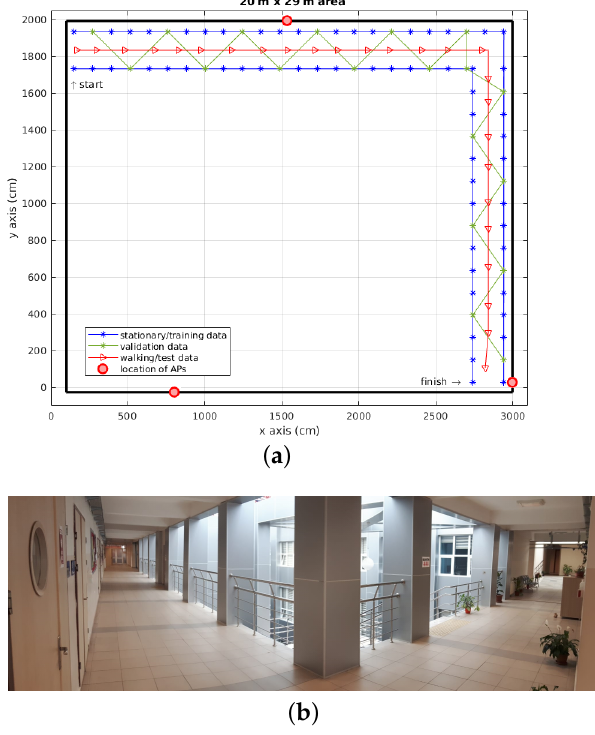
Figure 3. ( a ) The layout of the experimentation site with the positions of the reference points and APs (only the locations of APs on the same floor are indicated). The blue points represent the reference points from which the measurements are collected using a stationary scenario. The green points represent a novel set of reference points split for validation data. The red line is the trajectory from which the measurements are collected using a walking scenario. ( b ) Various numbers of APs are detected at each reference point. A total of 45 APs were detected. This number varies depending on the location. The lowest number of APs was observed at reference points around elevators, walls, and light wells in the